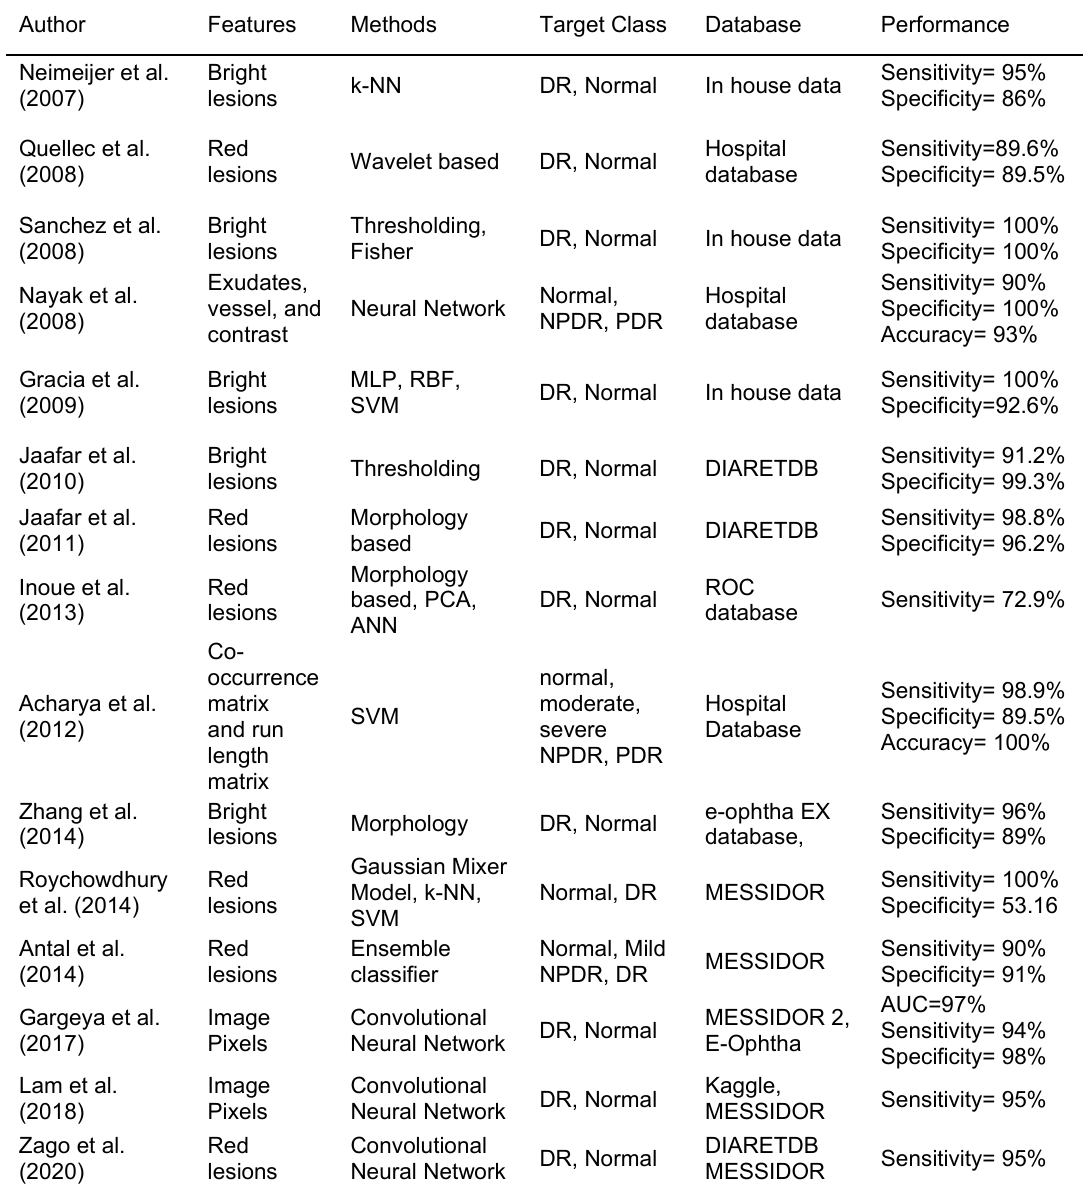
Table 1. State-of-the-art for DR